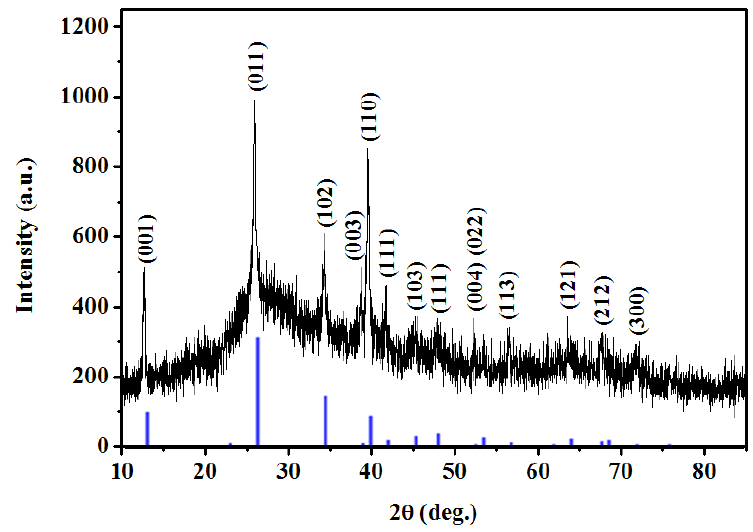
Figure 1. XRD diagram of PbI 2 /polyvinylpyrrolidone (PVP) composite fibers obtained from the electrospinning experiment using a precursor solution of 4.55 wt% PVP with 16 kV applied voltage, 10 cm spinning distance and flow rate of 1 mL/h. The Blue peaks are from JCPDs No. 80–1000 of PbI 2 .